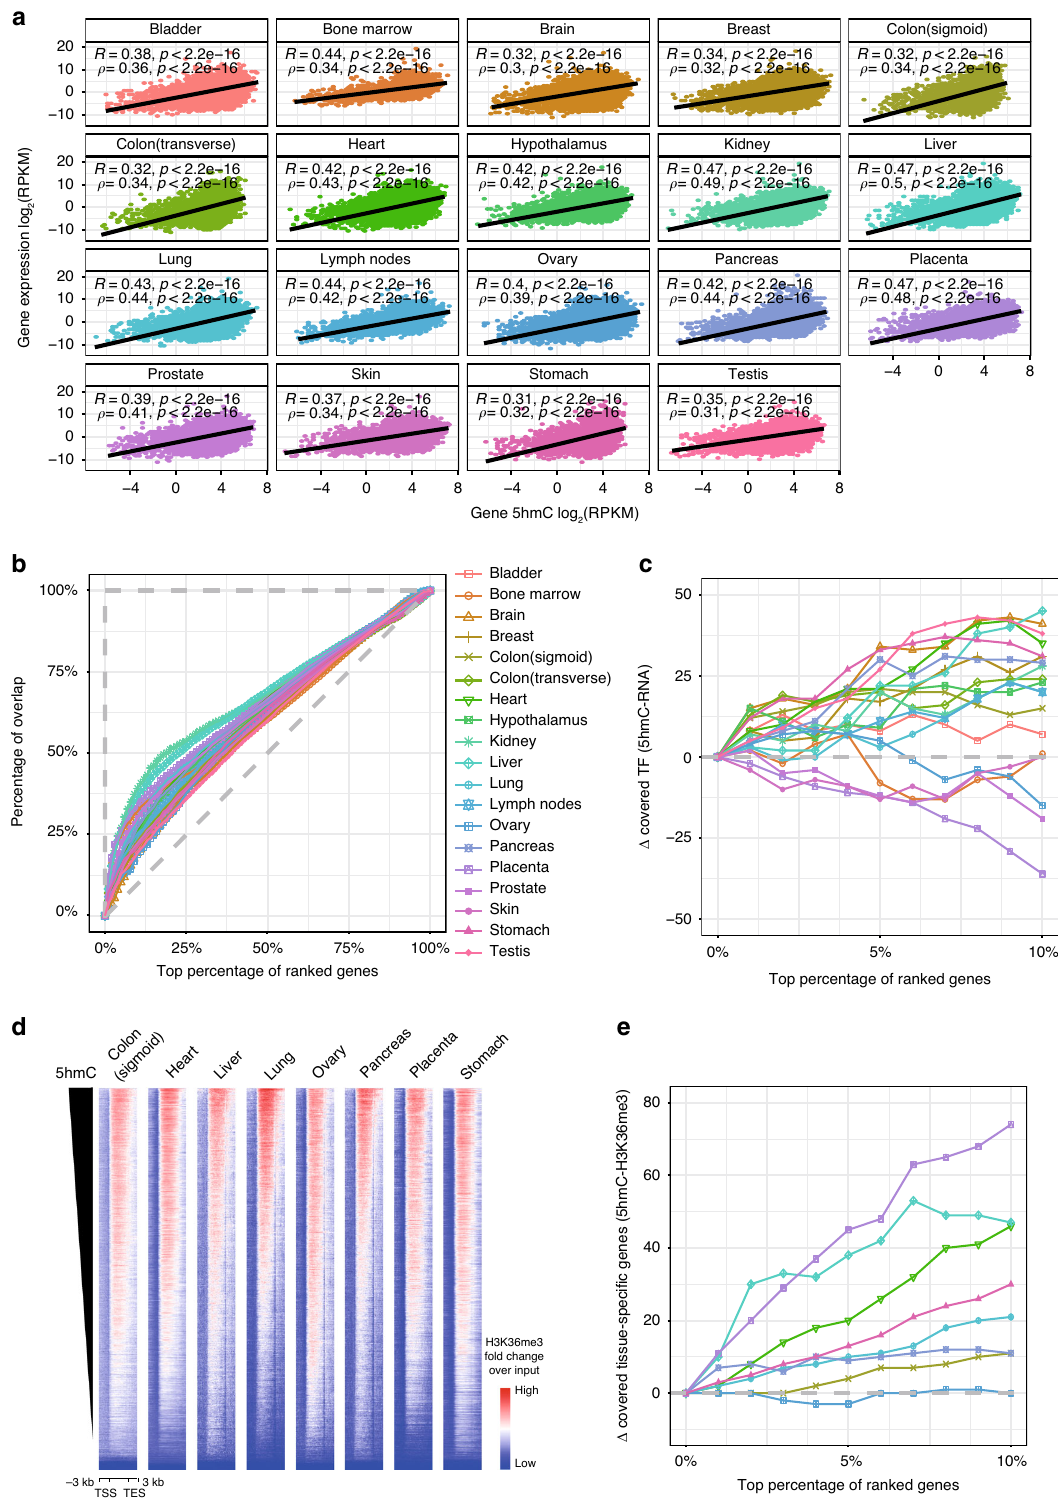
Fig. 3 Enrichment of 5hmC on tissue-speci fi c genes. a Scatter plots showing correlation of gene-body 5hmC levels with gene expression levels. R represents the Pearson correlation coef fi cient, and ρ represents the Spearman correlation coef fi cient. b Correspondence at the top (CAT) plot showing percentages of gene overlap against top percentages of 5hmC-modi fi ed genes and expressed genes. Diagonal dashed line represents results from two random gene sets, and the horizontal dashed line represents results from two exact gene sets. c Subtractions of covered transcription factors for top 10% 5hmC-modi fi ed genes and top 10% highly expressed genes. d Heatmaps showing correlation of gene-body 5hmC levels with gene-body H3K36me3 levels. TSS, transcription start site. TES, transcription end site. e Subtractions of covered tissue-speci fi c expressed genes for top 10% 5hmC-modi fi ed genes and top 10% H3K36me3-modi fi ed